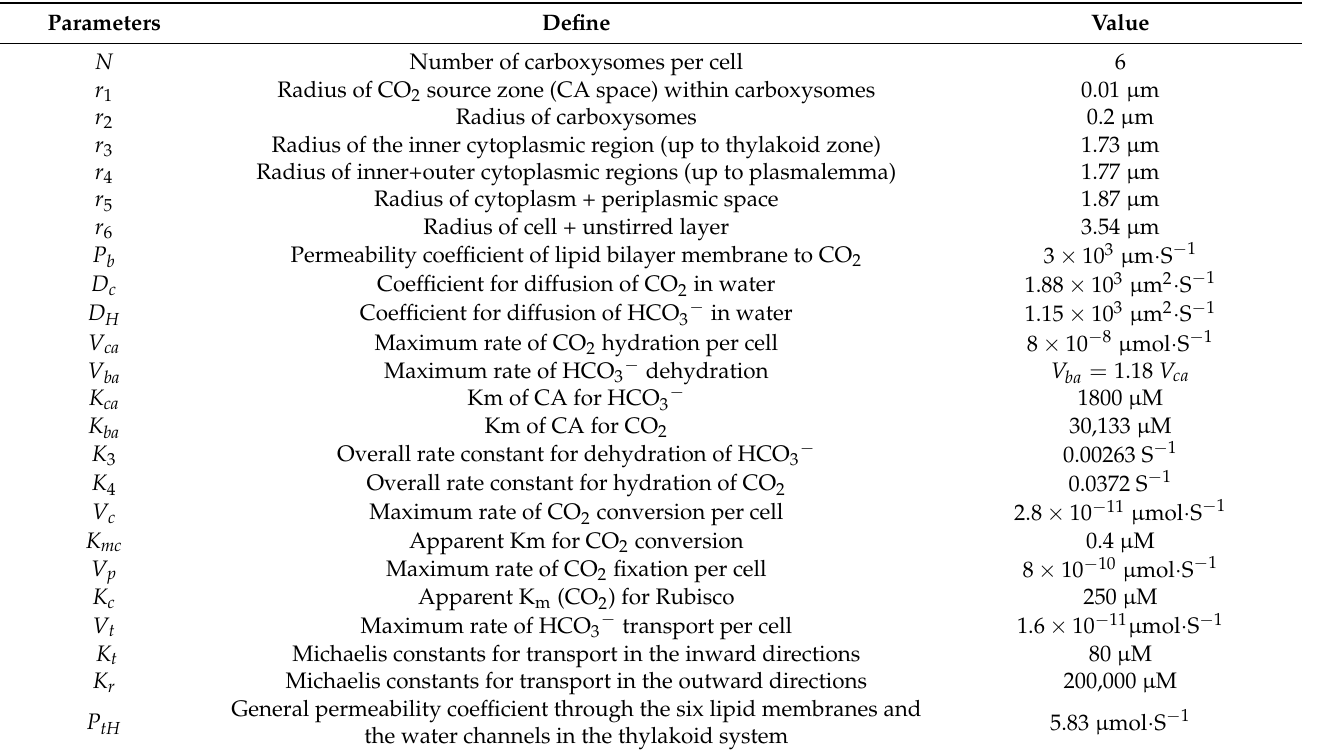
Table A1. The parameters of CCM model